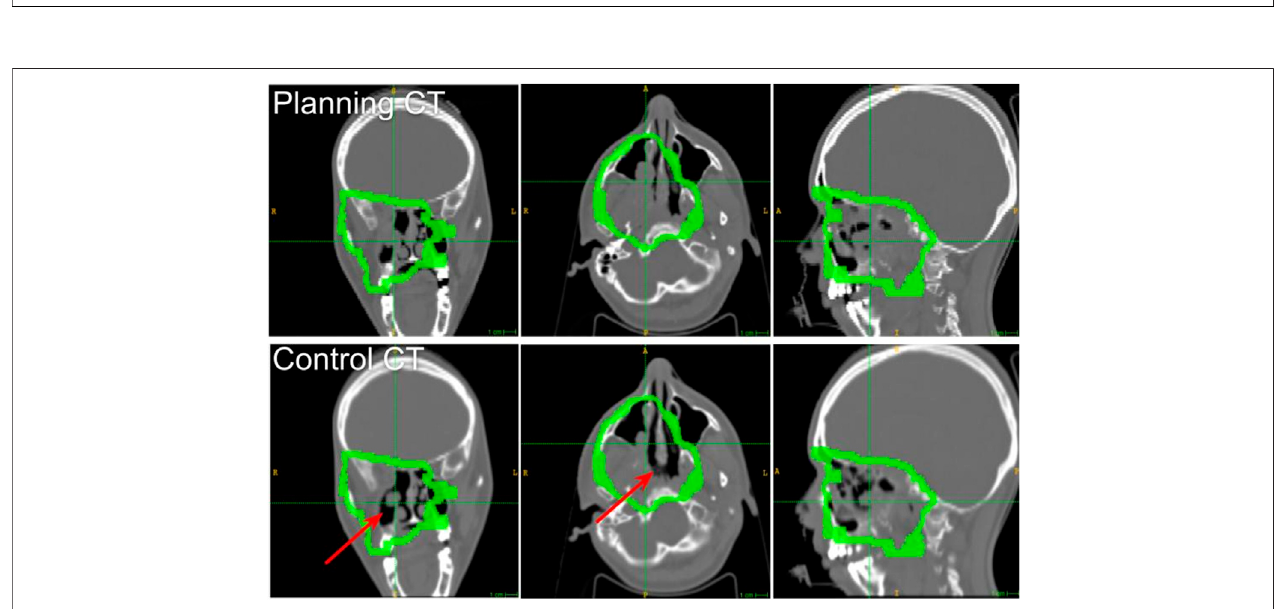
FIGURE2| Slicesoftheplanningand controlCTsofthe006Ppatientat theisocenter(fromlefttoright:axial,sagittal,andcoronal).Theisocenter isat thecrossing point of the dashed lines. The CTV margins are drawn in green. The emptied region is pointed out with the red arrow.